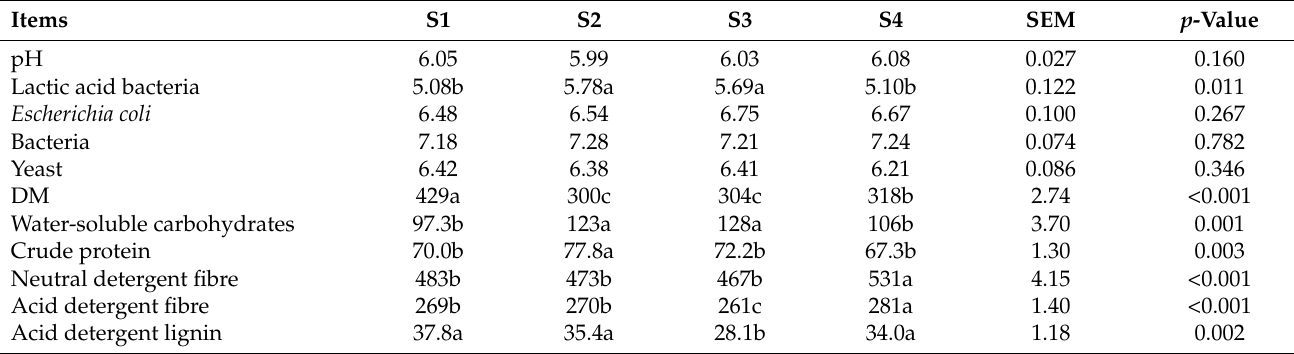
Table 1. pH, microbial counts (log 10 CFU/g fresh weight), dry matter content (DM, g/kg), and chemical component concentrations (g/kg DM) of whole-plant corn before ensiling (n =